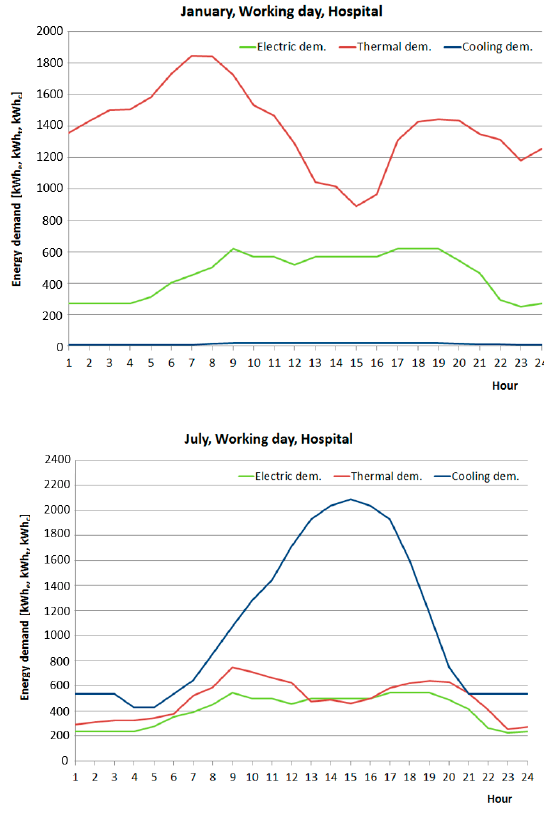
Figure 4. Hospital hourly energy demand patterns for a typical working day in winter ( top ) and